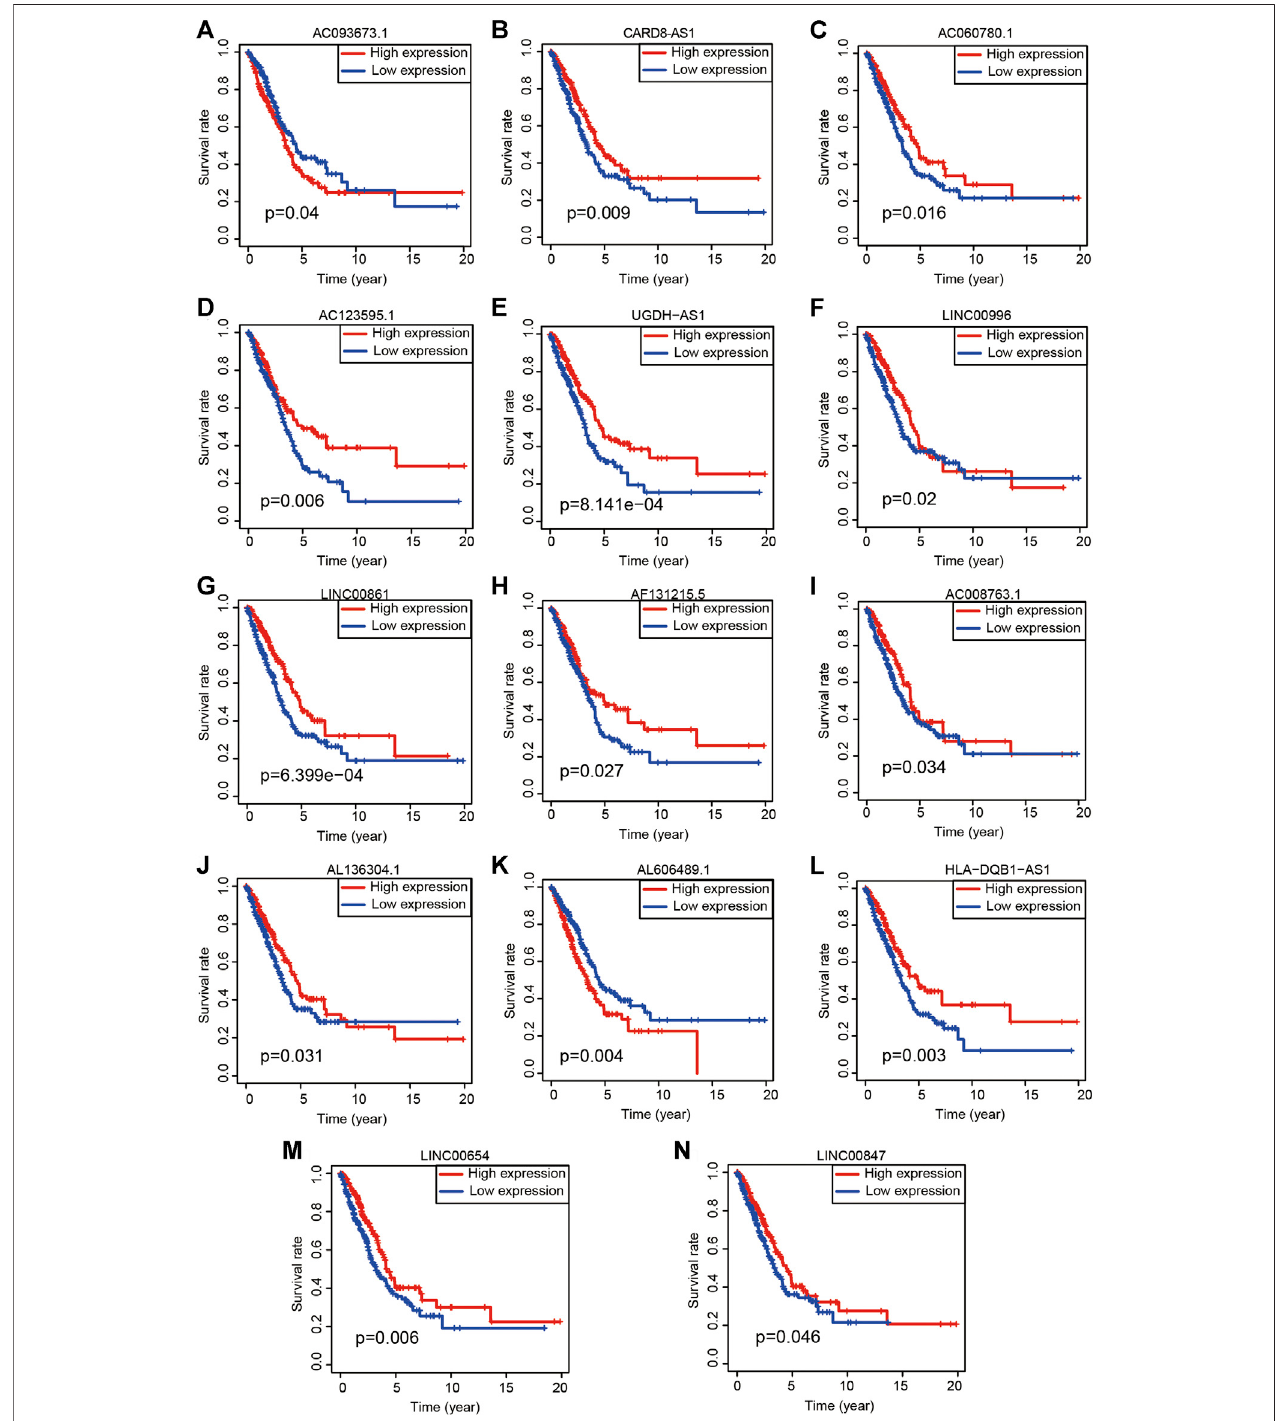
FIGURE 4 | Kaplan-Meier survival analyses of 14 ARlncRNAs included in the modeling process. ( A – N ) The survival curves of 14 ARlncRNAs included by the multivariate Cox regression.